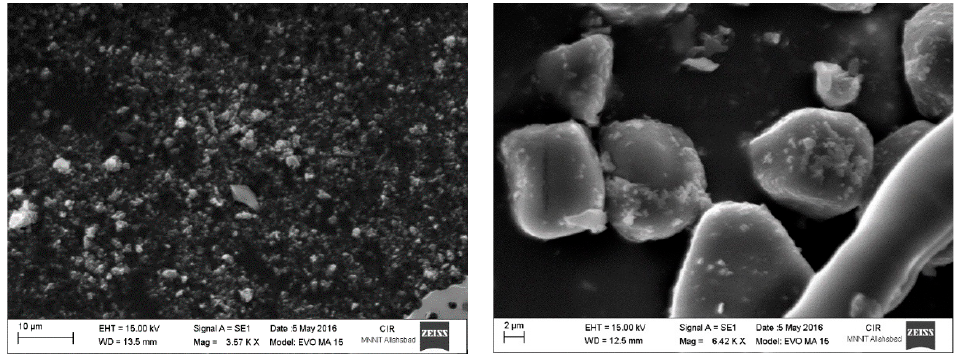
Figure 1. Surface morphology of CPX-loaded chitosan nanoparticles after lyophilization with tre- halose cryoprotectant using scanning electron microscopy (SEM) image analysis.